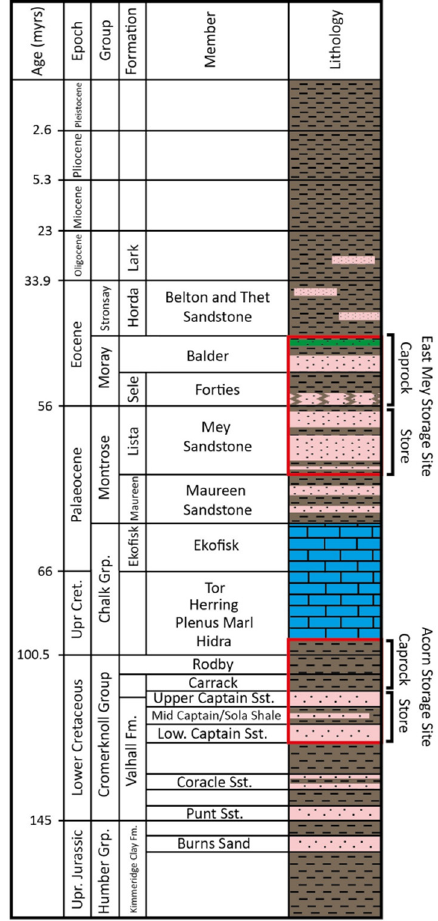
Figure 2. Lithostratigraphy of the Acorn and East Mey CO 2 Storage Sites. The pairs of site lithologies are highlighted in red. The Captain Sandstone Member, part of the Lower Cretaceous Valhall Formation, is the reservoir for the Acorn Site which has the Rodby and Carrack Formations as the top-seal. The Captain Sandstone contains the intraformational Sola Shale that may result in internal compartmentalisation of the Captain Sandstone reservoir. The Mey Sandstone Member, part of the Palaeocene Lista Formation, is the reservoir for the East Mey Site, which has an overlying Lista Formation Shale, together with Eocene Sele Formation, as the top-seal. The approximately 56 Ma East Mey CCS reservoirs and top-seals are at approximately 7100 ft true vertical depth. The approximately 100 Ma Acorn site has undergone slower sedimentation over a longer period, than the East Mey site, since the older Acorn reservoirs and top-seals are at approximately 6500 ft true vertical depth. Modified after Pale-Blue-Dot-Energy [9], Pale-Blue-Dot-Energy